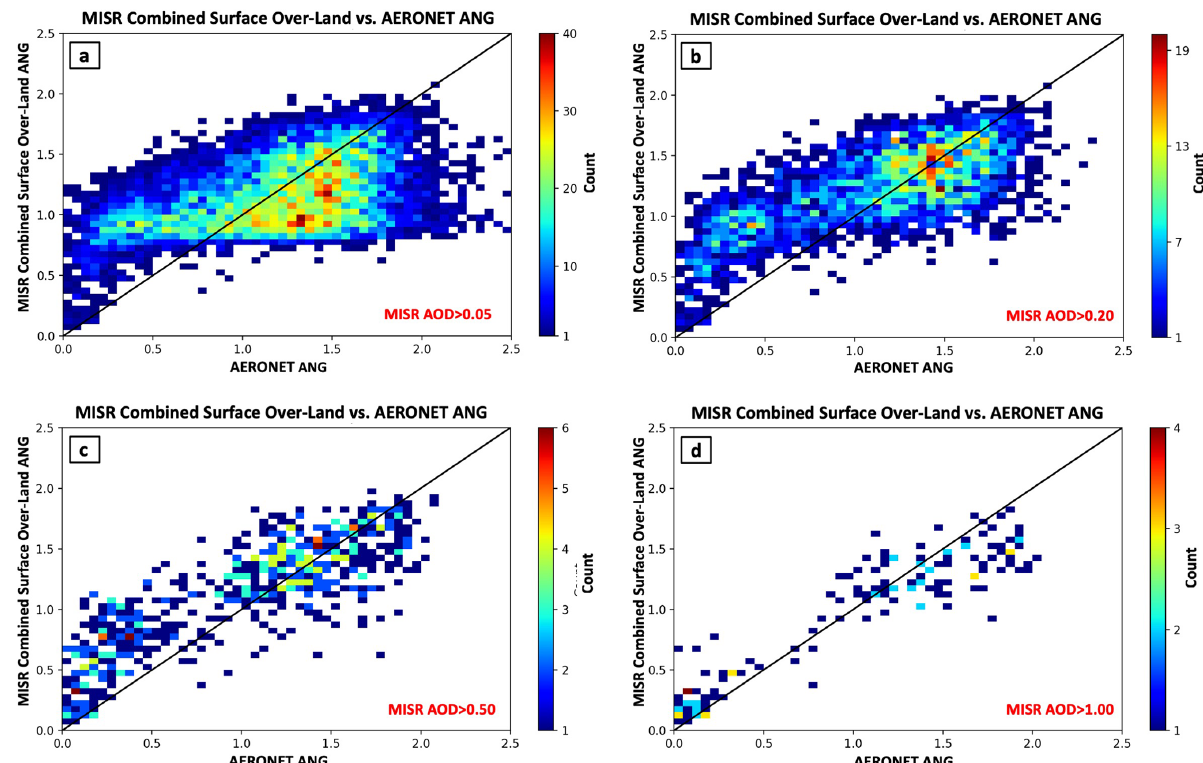
Figure 4. Two-dimensional histograms of the MISR RA combined surface algorithm over-land ANG compared to AERONET ANG. The x axes are AERONET ANG and y axes are the MISR combined surface algorithm over-land ANG. Panel (a) shows MISR ANG vs. AERONET ANG constrained by MISR-retrieved AOD > 0 . 05. Panels (b)–(d) show the same as (a) , but for MISR-retrieved AOD con- straints of > 0 . 20 (b) , > 0 . 50 (c) , and > 1 . 0 (d) . Table 4. MISR RA vs. AERONET almucantar inversion statistics over land. Same as Table 3, except for MISR RA vs. AERONET inversion statistics over land. All MISR data correspond to the combined surface algorithm. Note that AERONET inversion results are not ground truth; they represent retrieval results. The AERONET team cautions against the use of results when blue-band AOD < 0 . 4, so comparisons for green-band AOD < 0 . 50 should be considered qualitative rather than